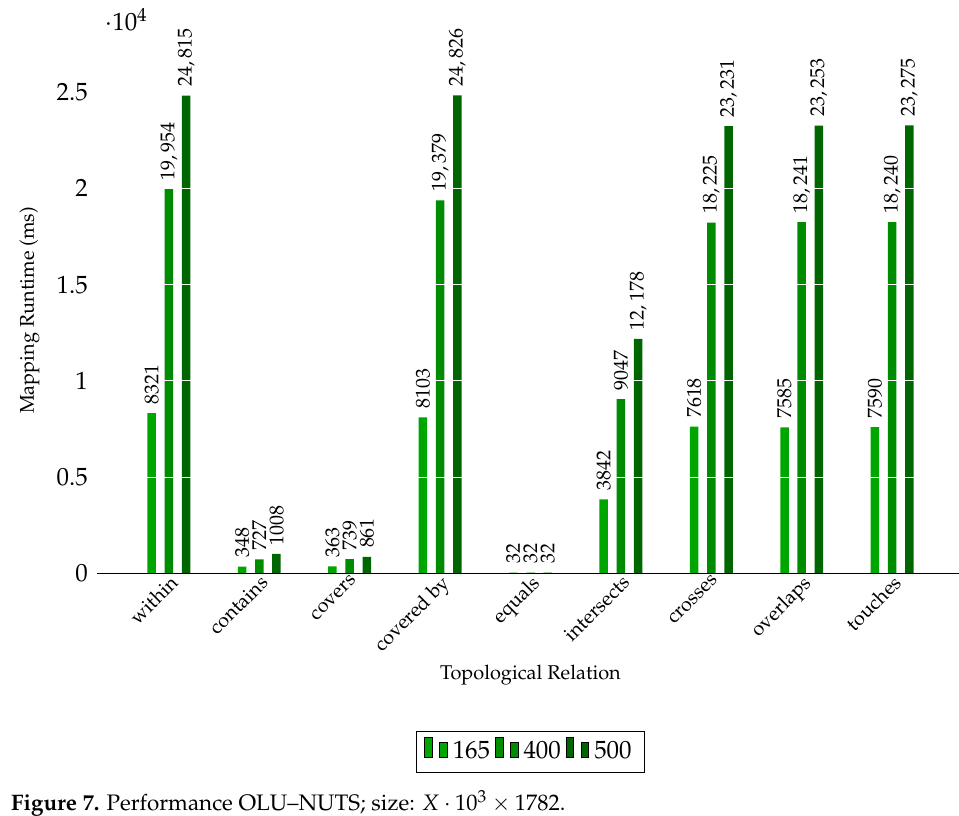
Figure 7. Performance OLU–NUTS; size: X · 10 3 × 1782.